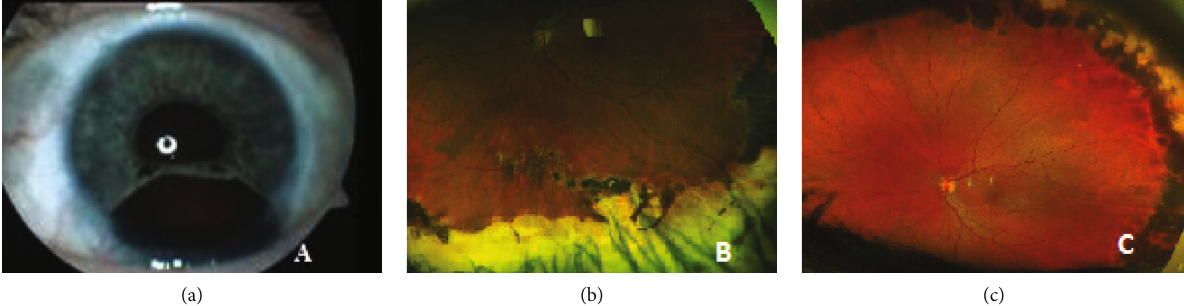
Figure 3: (a, b) Iris coloboma of the left eye following surgical treatment for medulloepithelioma (a) (Zeiss Clarius 700) and status following resection of the tumor (b) and laser-photocoagulated retina in the periphery (c) (Optos California) are shown. These images are taken 20 years following surgical removal of the malignant